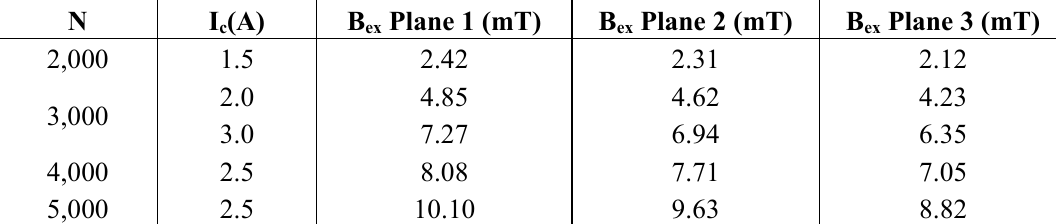
Table 7. Results of the magnetic flux density in the center of the air gap using different